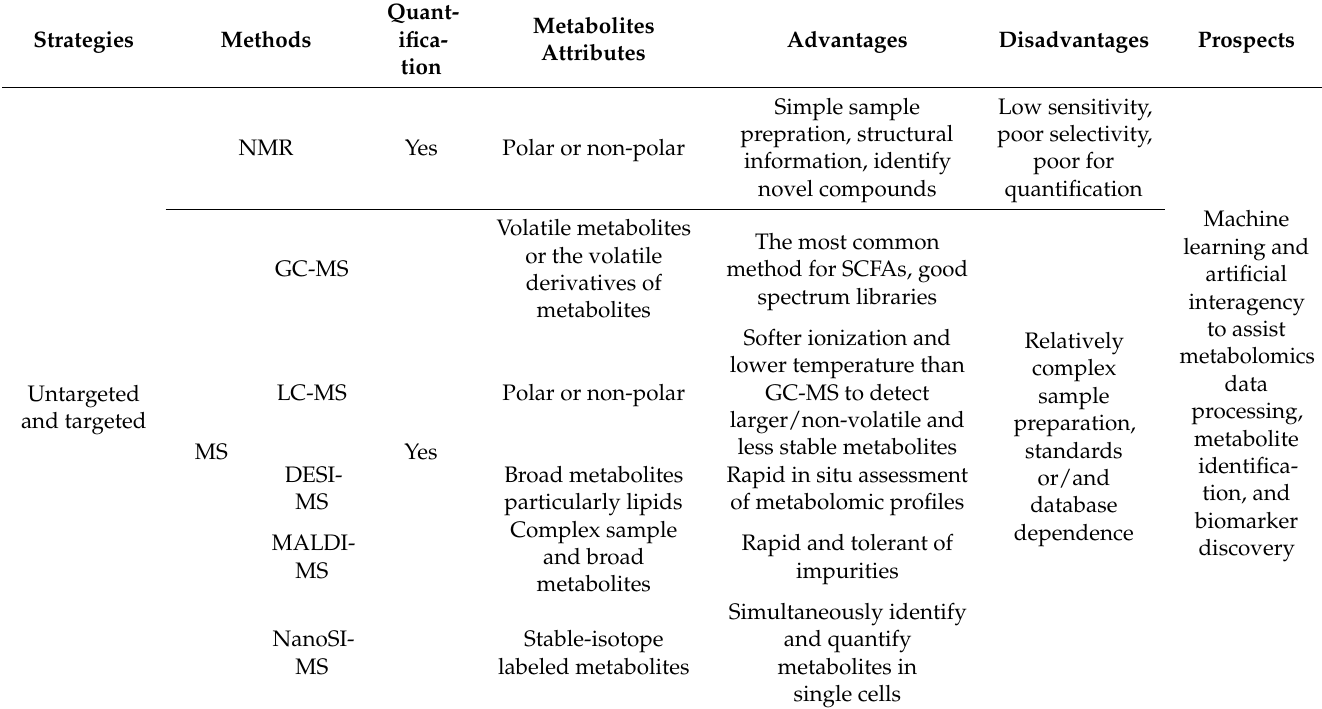
Table 1. The common metabolomics methods in host-microbiome studies.